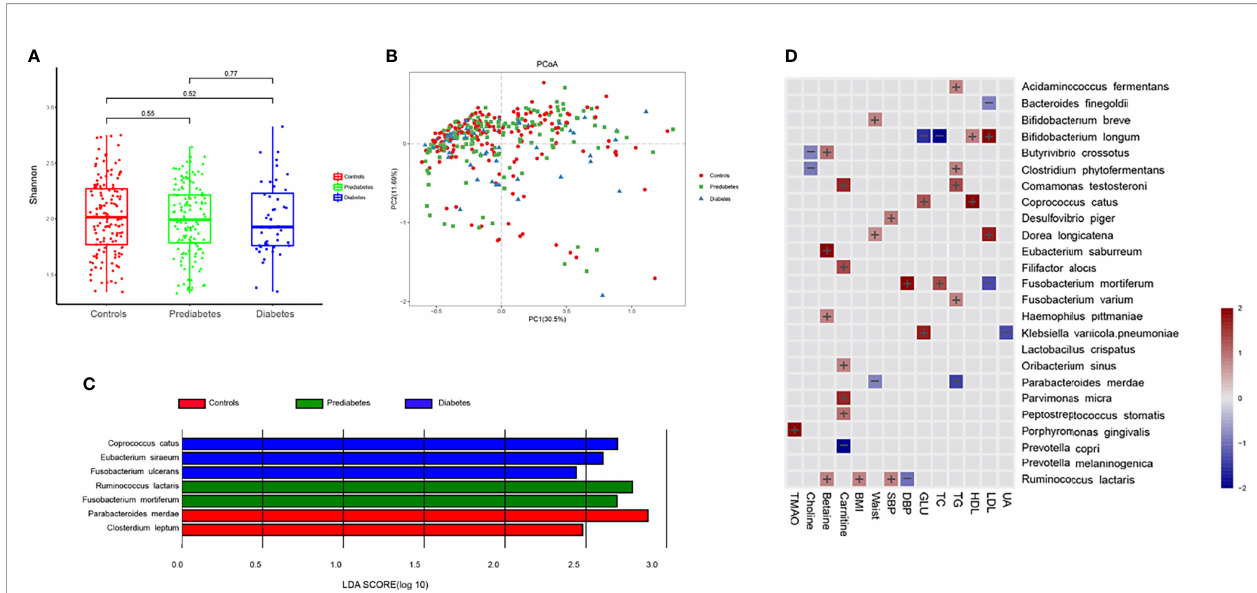
FIGURE 2 | Prediabetes and diabetes-associated intestinal microbiota. (A) Box plot showing the species-based a -diversity (Shanon index) in controls, prediabtes, and diabetes. (B) Species-based principal coordinates analysis (PCoA) of controls, prediabtes, and diabetes. (C) Linear discriminant analysis (LDA) effect size (LEfSe) analysis revealed signi fi cant bacterial differences in fecal microbiota in controls, prediabtes, and diabetes. (D) Associations between clinical parameters, intestinal microbiota-generated metabolites and microbial species were estimated by